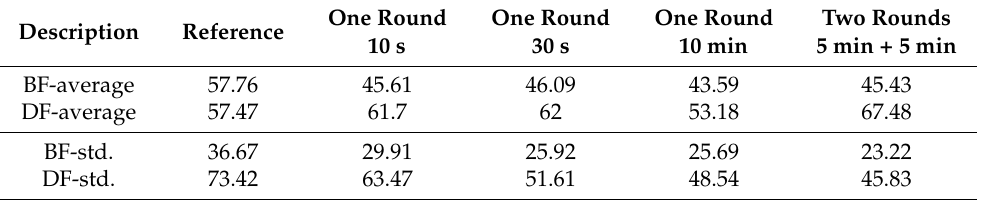
Figure 9. The optical micrographs of the solar cells with different deposition times of SiO 2 nanosphere coatings: ( a – e ) The brightfield images and ( f – j ) the corresponding grayscale image histograms; ( k – o ) Darkfield images and ( p – t ) the corre- sponding grayscale image histograms. The scale bar is 10 µ m. Table 2. Statistical analysis of brightfield (BF) and darkfield (DF) grayscale